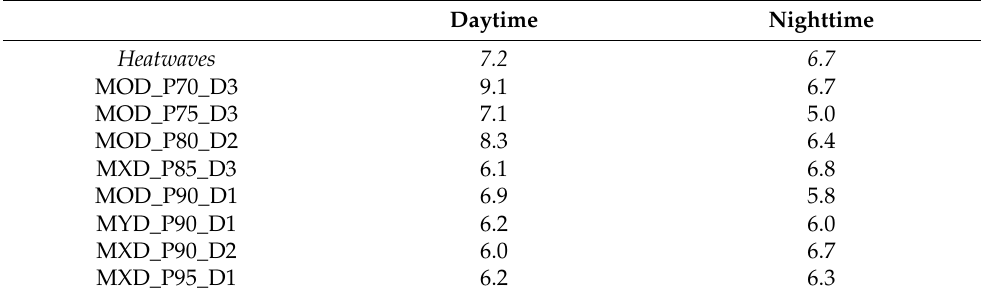
Table 1. Mean annual frequencies (number of days, HWF) of heatwaves (CTX90pct & CTN90pct; in italic font) and LST anomaly days (the 10 best performing indices are shown).